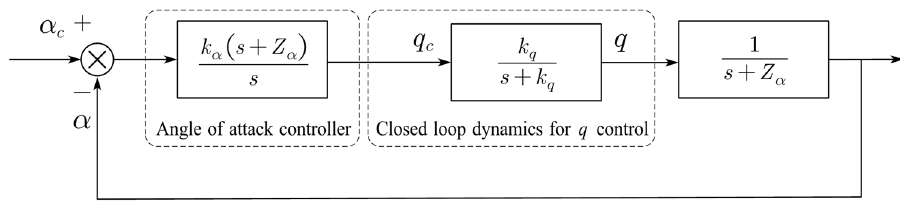
Figure 16. Diagram of the angle of attack controller.